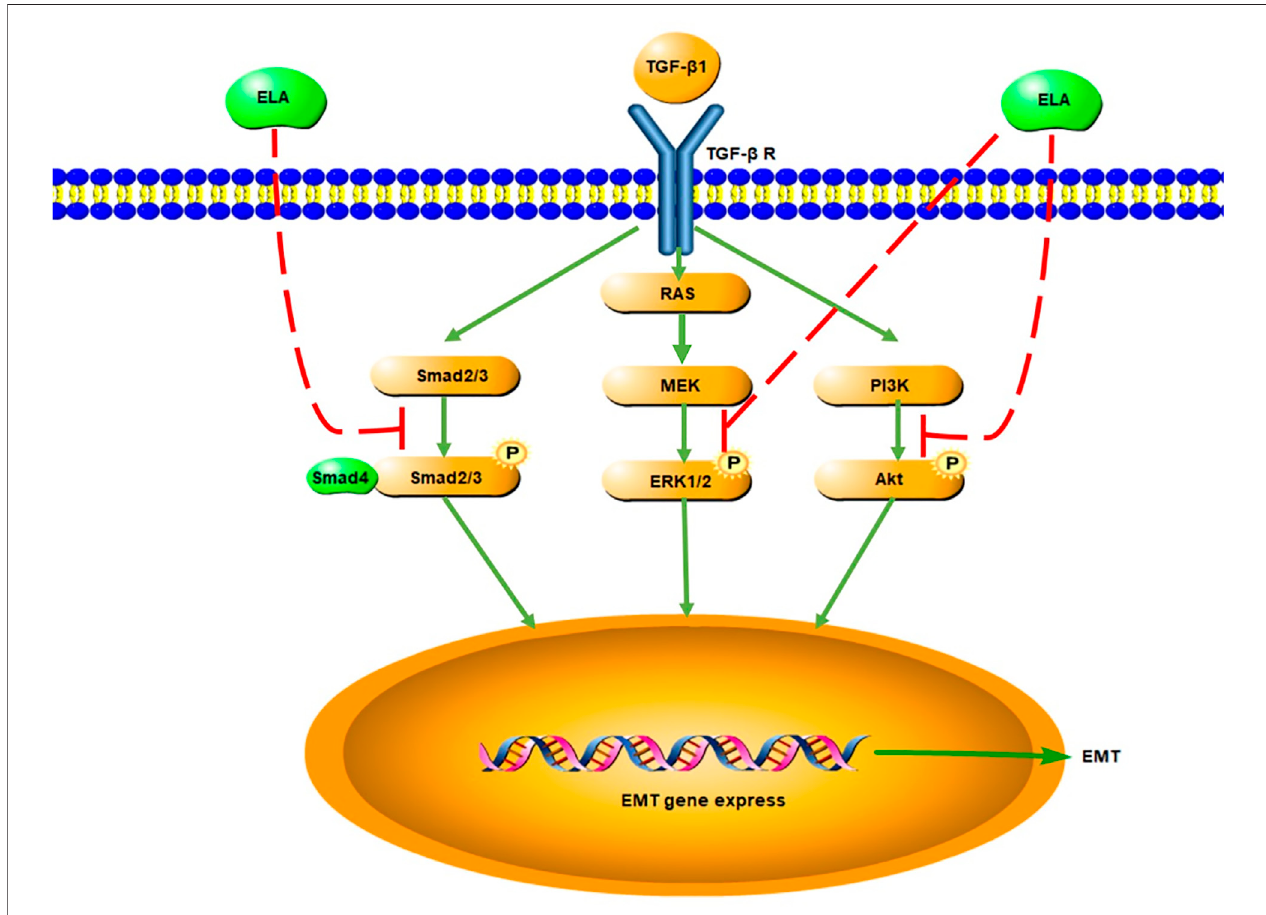
FIGURE 5 | Signaling pathway diagram of ELA inhibiting EMT in